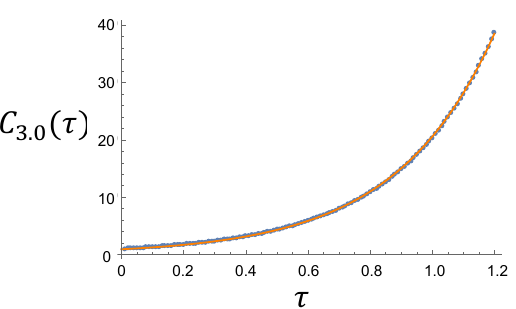
Figure 9 . Points: numerically calculated C T ( (cid:28) ) in (5.7), with T = 3 : 0 as a function of (cid:28) . Line: a (cid:12)tting of the points by (cid:11)e L(cid:28) with constant (cid:11) and L .